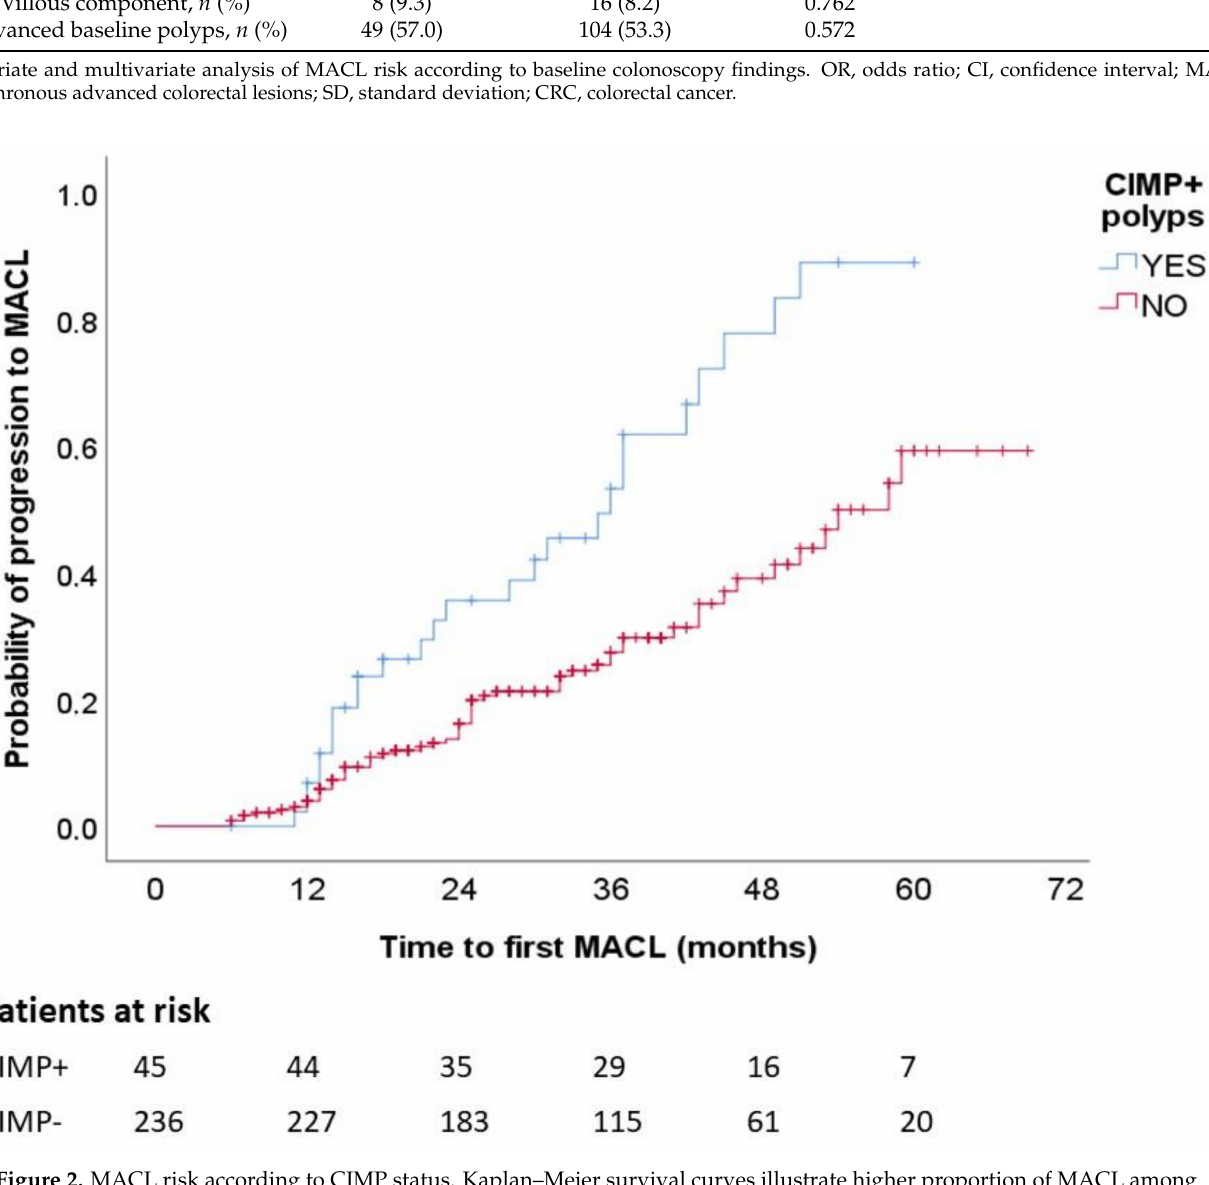
Figure 2. MACL risk according to CIMP status. Kaplan–Meier survival curves illustrate higher proportion of MACL among patients with CIMP+ polyps. MACL, metachronous advanced colorectal lesion. p <